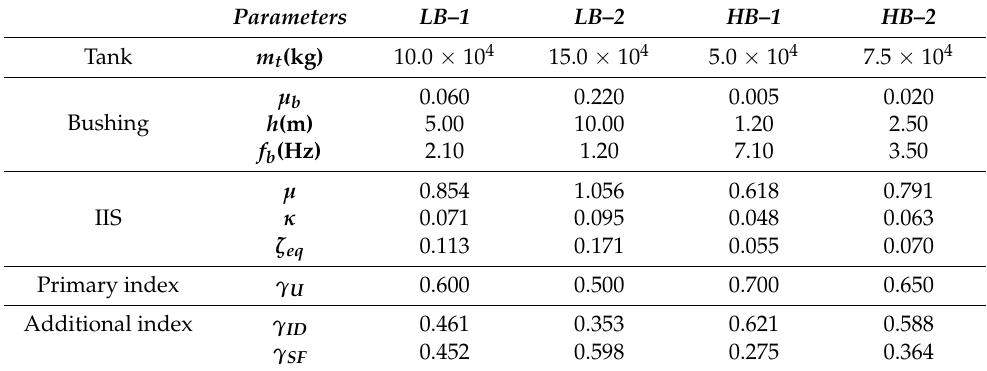
Table 2. Results of parameters of IIS obtained after